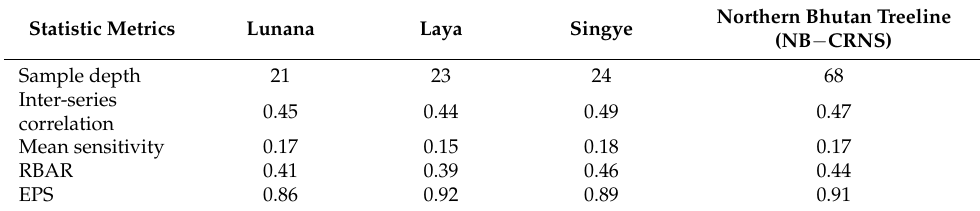
Table 1. Statistic metrics of COFECHA and ARSTAN.